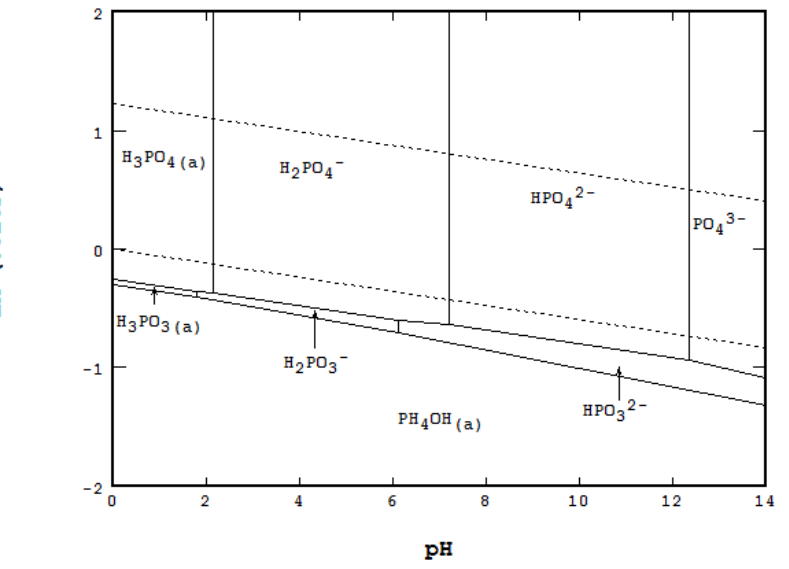
Figure 2. Eh pH diagram of a P-water system. Dissolved phosphorus species, [P] = 0.001 M.